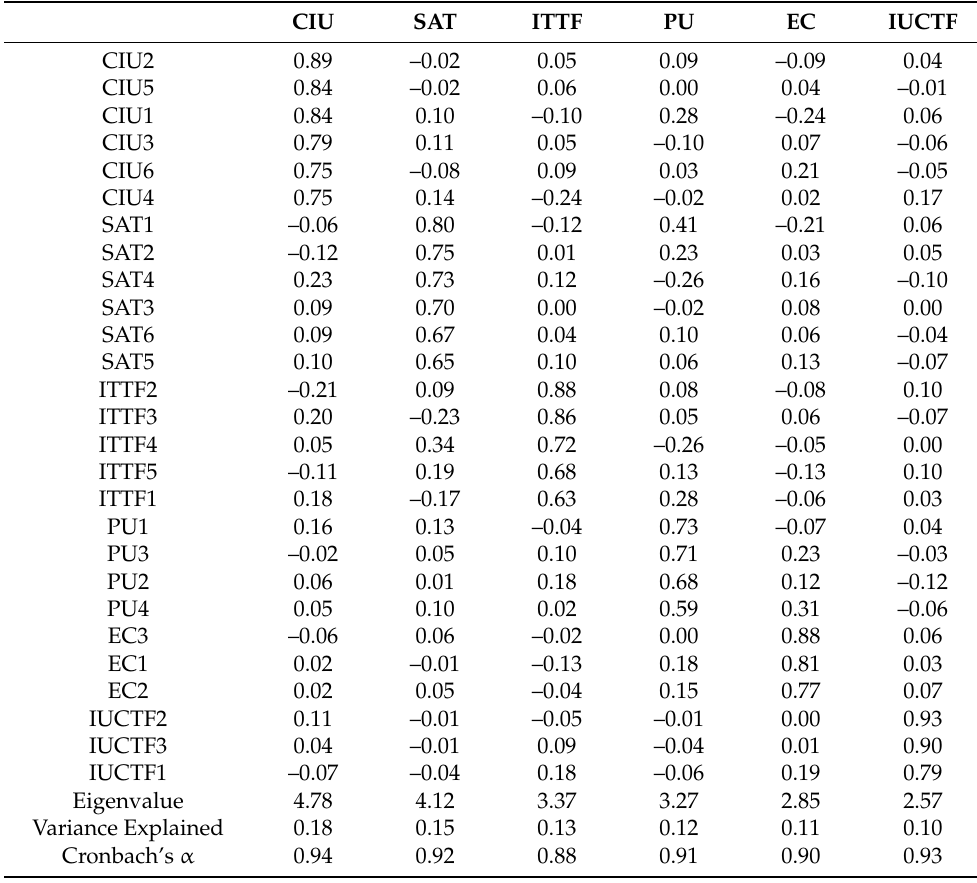
Table 4. Results of exploratory factor